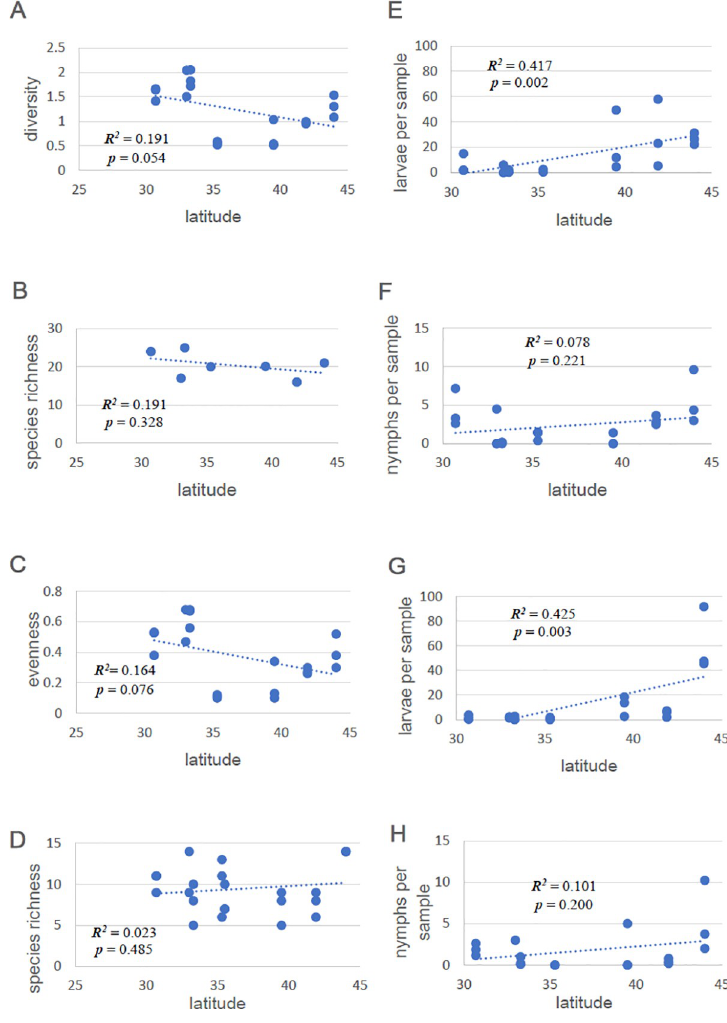
Fig 2. Latitudinal trends in host diversity and tick abundance. Species diversity of mammals + reptiles at field sites as a function of latitude. ( A ) Shannon–Wiener Index (H’) for trapped species at each sampling array. ( B ) Species richness (overall for each of 7 sites; estimated total number of species from trap data, using SPECRICH). ( C ) Evenness (1-BP) of species captured in traps at each sampling array. ( D ) Species richness (number of species) of animals photographed by remote cameras at each sampling array. Latitudinal trends in tick abundance (mean numbers of ticks on all hosts collected in each sampling array) of ( E ) larvae in 2011, ( F ) nymphs in 2011, ( G ) larvae in 2012, and ( H ) nymphs in 2012. The Rhode Island site used only mouse traps and vertebrate trapping was limited at the North Carolina site (no pitfall traps), so these sites are not included in the figures or the accompanying analyses. Data for